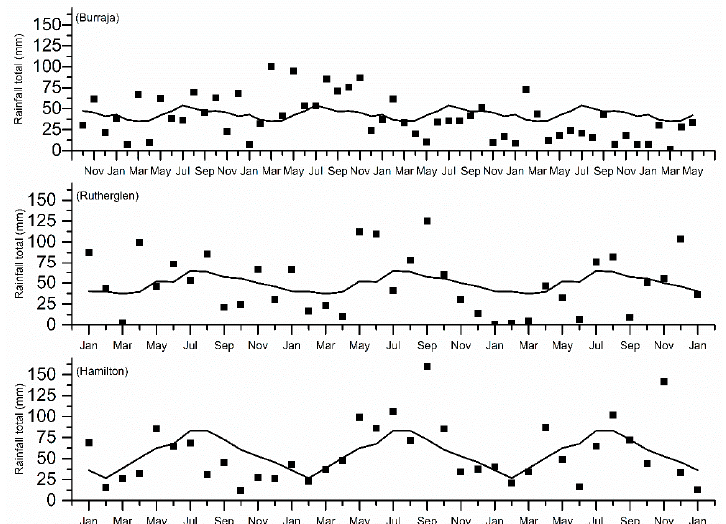
Figure 2. Monthly rainfall (mm, black squares) and long term average rainfall (LTA, 1970–2015, mm, black line) at Burraja from November 1998 to May 2003 (top); monthly rainfall (mm, black squares) and LTA rainfall (1965–2015, mm, black line) at Rutherglen from January 2015 to January 2018 (middle); monthly rainfall (mm, black squares) and LTA rainfall (1965–2015, mm, black line) at Hamilton from January 2015 to January 2018 (bottom).